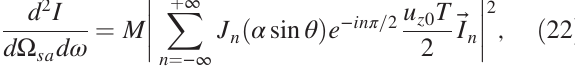
6(a) = ½ N x-ray radiation spectrum d 2 N ð γ 0 θ Þ d ð γ 0 θ Þ d κ (cid:2) gen- ph e erated by two beating laser pulses f m ¼ 0 ; n ¼ 0 ; a ¼ 0 . 21 ; r ¼ 1 . 14 ; φ ¼ 0 g and f m ¼ 1 ; p ¼ 0 ; a ¼ 0 . 15 ; m r ¼ 1 . 14 ; φ ¼ 0 g after n ¼ 30 periods of oscillations, m u